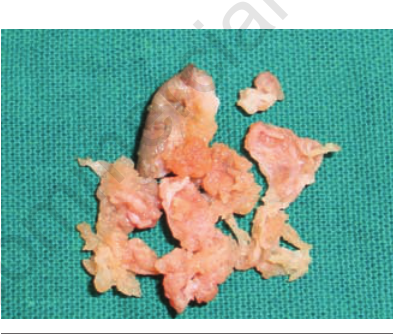
Figure 5. Photomicrograph showing fibro- cellular connective tissue with stellate-